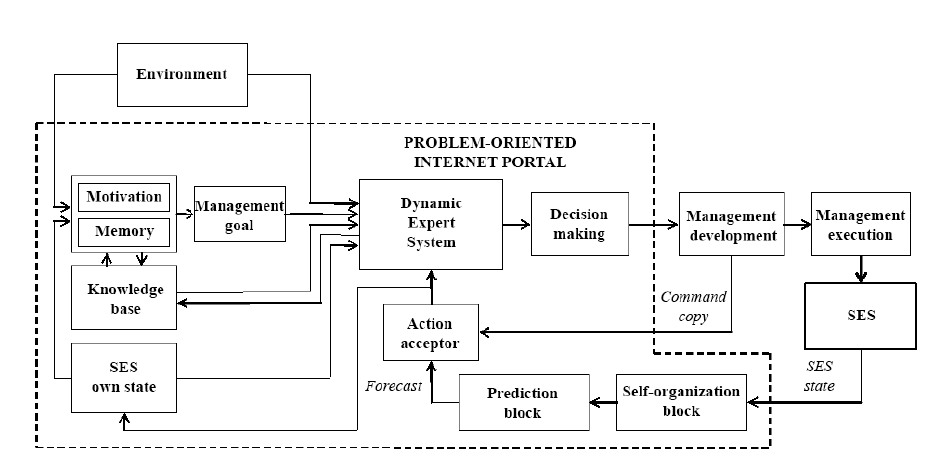
Fig. 2. The structure of the intellectual system for managing the innovative development of a complex socio-economic system based on a problem-oriented Internet